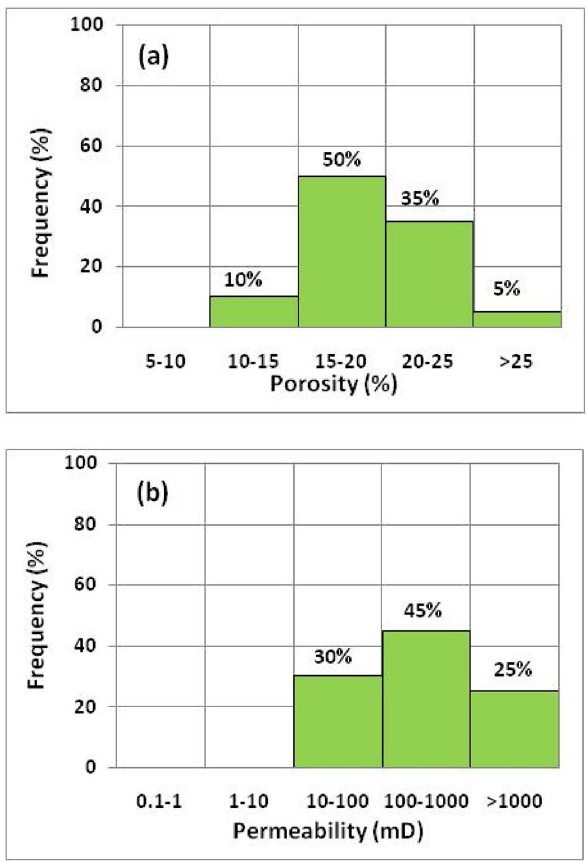
Fig. 4 Porosity and permeability histograms to show the petrophysi- cal variation in the Kaimiro